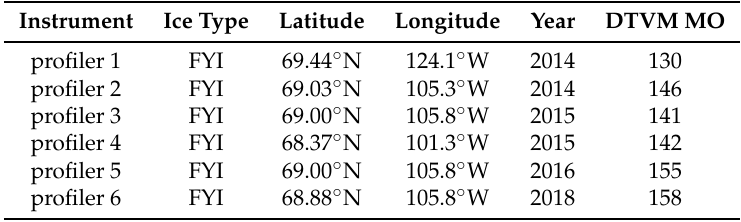
Table 2. Location and DTVM MO dates for temperature profilers in the study region.